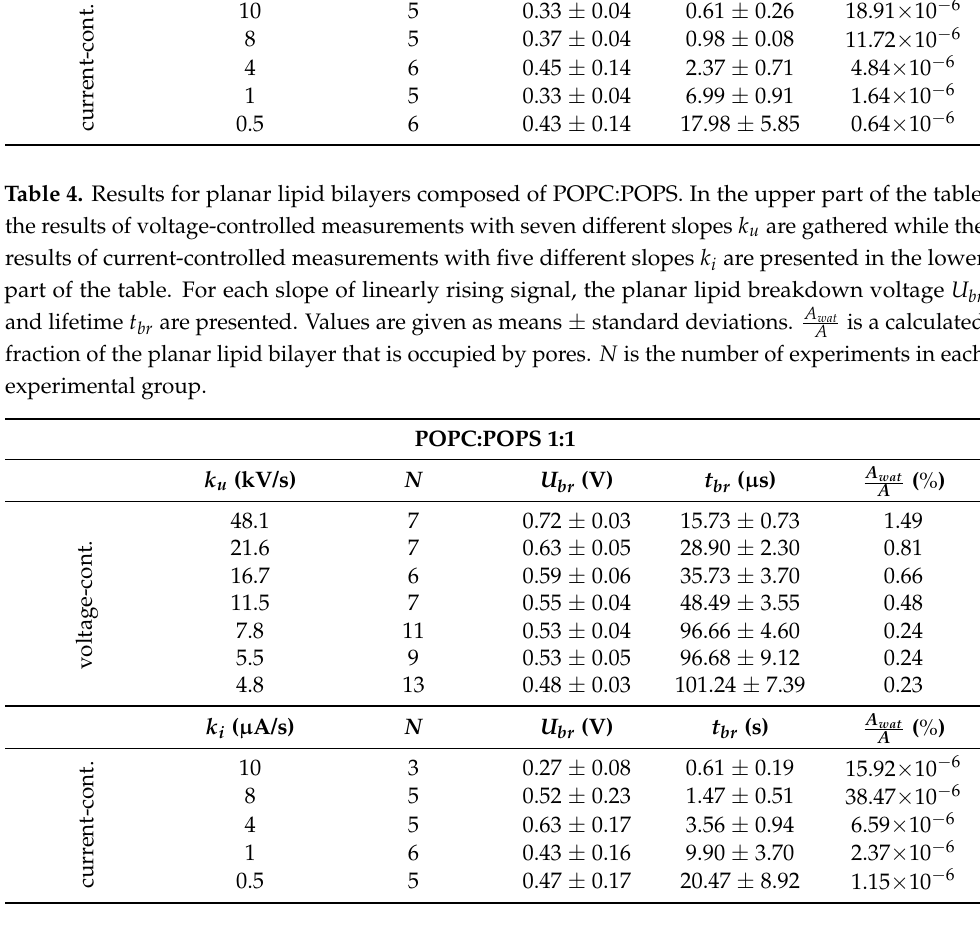
is a calculated A